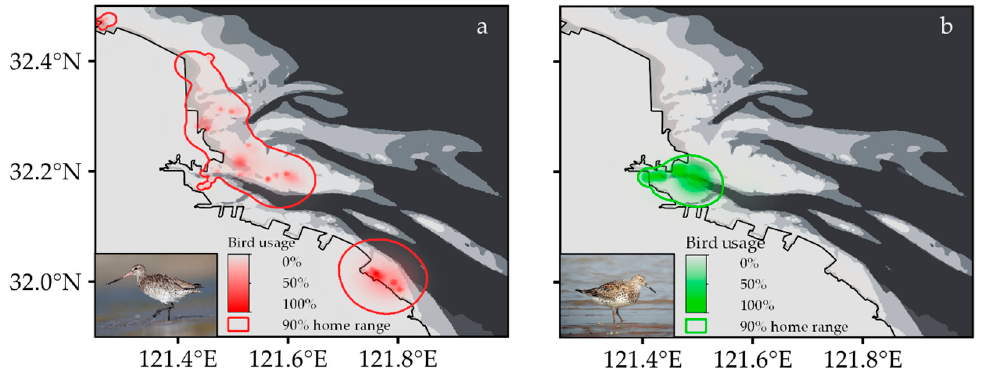
Figure 8. Ecotope map of Tongzhou Bay overlaid with Kernel density home ranges generated from satellite-tracking data of the ( a ) Bar-tailed Godwit and ( b ) Great Knot.